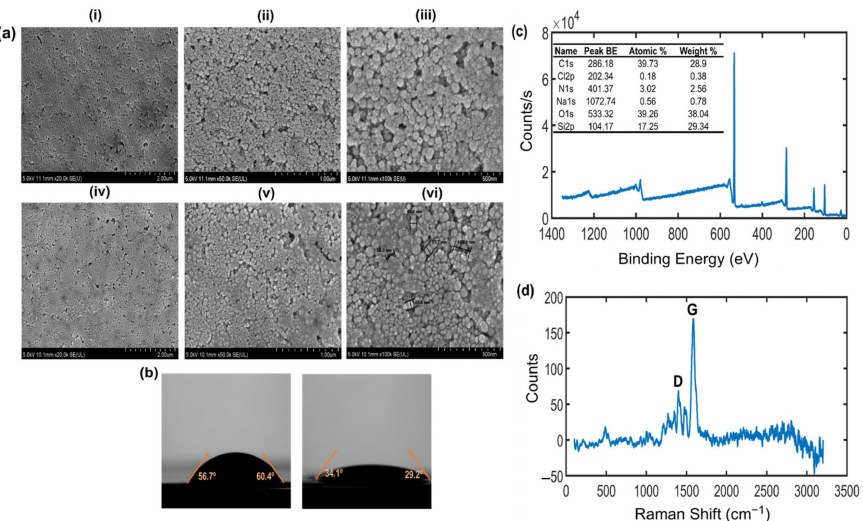
Figure 3. Characterization of paper-based inkjet-printed graphene. ( a ) FESEM images of bare glossy paper surface without printed graphene ink (i–iii) and glossy paper surface with printed graphene ink (iv–vi) in 2 µ m scale, 20 K magnification; 1 µ m scale, 50 K magnification; 500 nm scale, 100 K magnification, respectively. ( b ) Surface contact angles of glossy paper without printed graphene ink (left) and with printed graphene ink (right). ( c ) Raman spectrum of glossy paper with printed graphene ink. ( d ) XPS of glossy paper surface with printed graphene